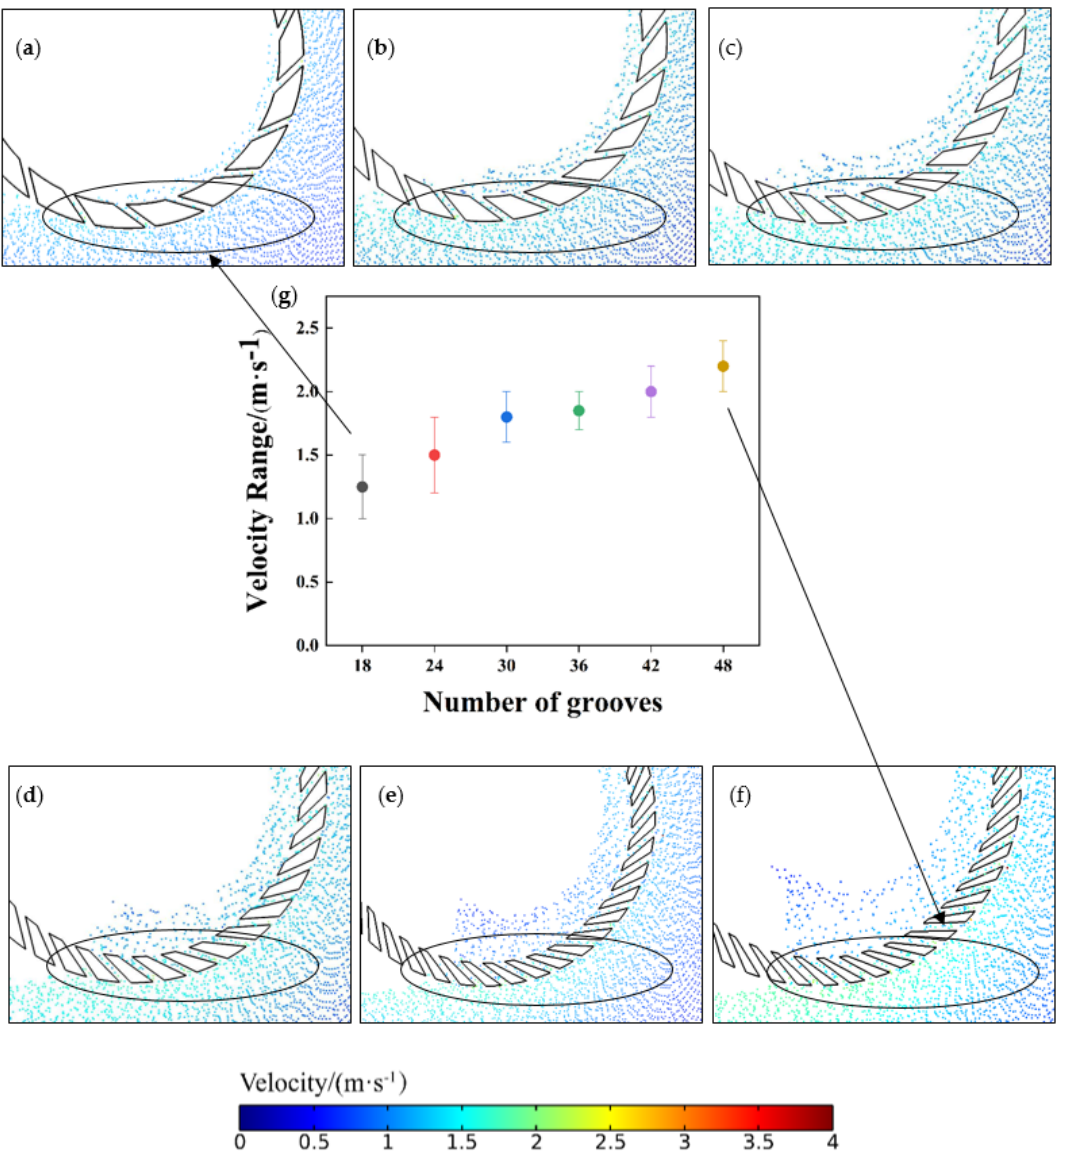
Figure 12. Nephogram of the abrasive speed gradient at the entrance of the ring was maintained with different numbers of grooves: ( a ) 18, ( b ) 24, ( c ) 30, ( d ) 36, ( e ) 42, ( f ) 48. Range of abrasive velocities at the position of the retaining ring abrasive entrance with different groove numbers: ( g ) Range of abrasive velocities at the position of the retaining ring particle entrance with different groove